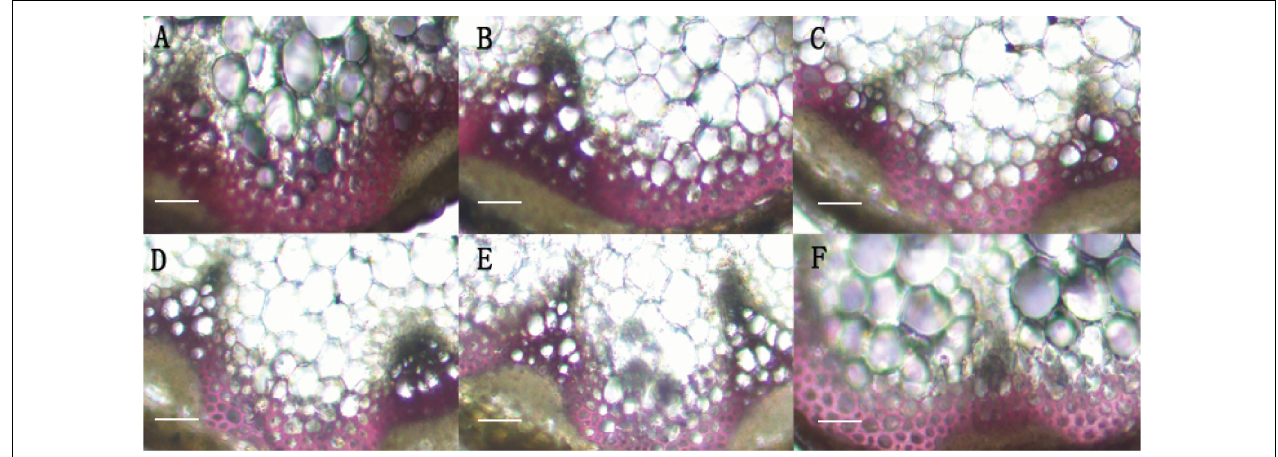
FIGURE 4 | Histological observation of transgenic Arabidopsis. (A) Histological observation of WT Arabidopsis. (B–F) Histological observation of transgenic Arabidopsis stems ( B: line 2; C: line 3; D: line 7; E: line 9; F: line 25). scale bar represent 50 µ m.